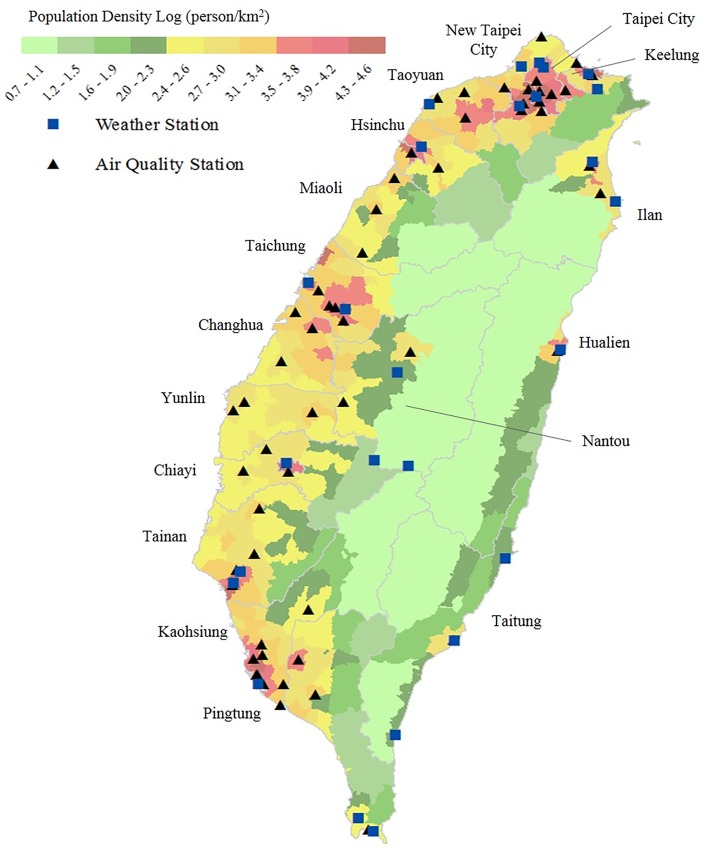
Locations of weather and ambient air quality monitoring stations and population density in Taiwan.